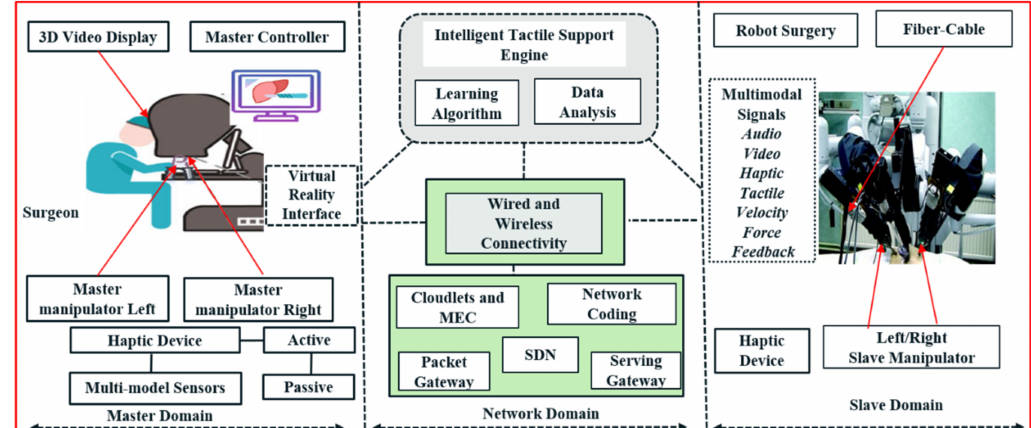
Figure 1. Smart hospital 5G-enabled low latency-tactile internet telesurgery architecture